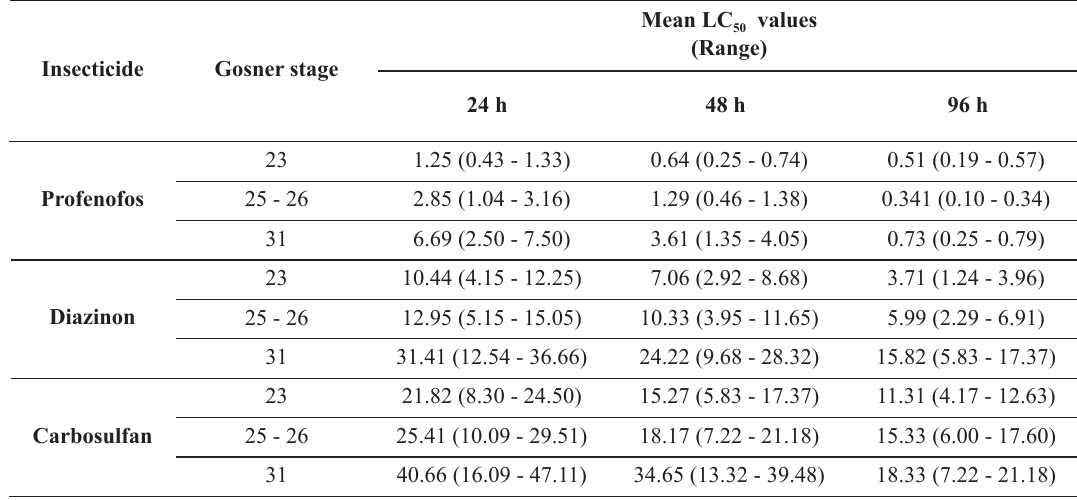
values of profenofos, diazinon, and carbosulfan obtained for different developmental stages of the common hourglass Table 2: The LC 50 tree frog, Polypedates cruciger at (A) Gosner stage 23 (B) Gosner stage 25 - 26, and (C) Gosner stage